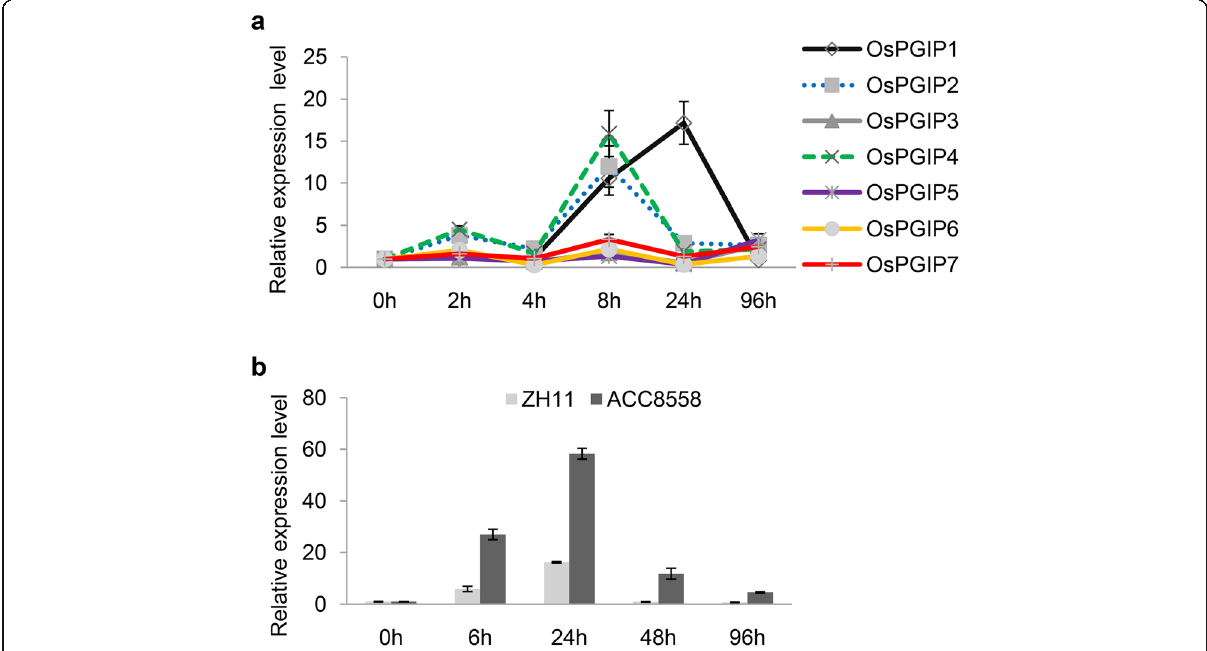
Fig. 1 Expression patterns of rice OsPGIPs in response to the Xanthomonas oryzae pv. oryzicola strain RS105. a Relative expression of OsPGIPs in ZH11 in response to Xoc . The gene expression levels of OsPGIP1 to OsPGIP7 were analyzed by qRT-PCR after inoculation with Xoc stain RS105 at 2, 4, 8, 24, and 96 h. b The expression of OsPGIP1 in response to RS105 at 6, 24, 48, and 96 h in the susceptible rice variety ZH11 and moderately resistant variety Acc8558. The housekeeping gene ACTIN was used to normalize the data. Error bars represent the standard deviations for three replicates. Three independent experiments were performed with the same expression